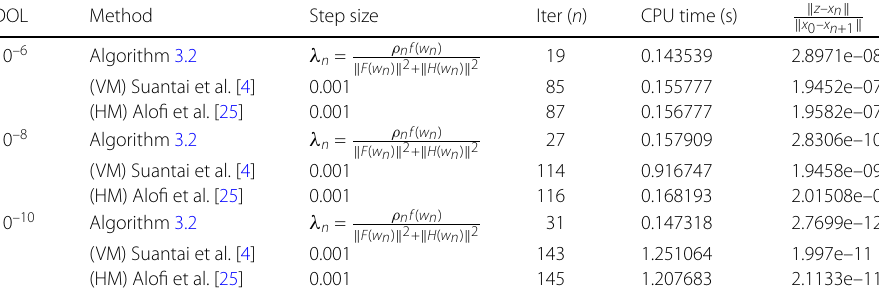
Table 3 Comparison of Algorithm 3.2 with other